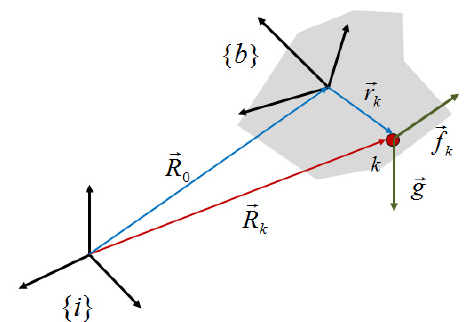
Figure 1. Inertial frame and body